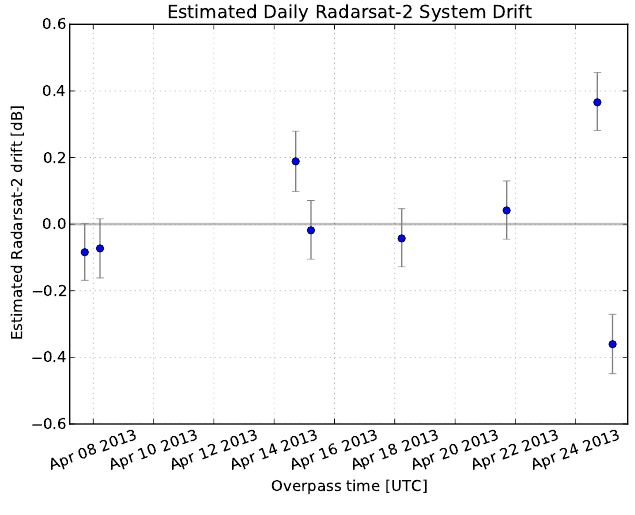
Figure 11. Estimated daily drifts r d of the RADARSAT-2 system. The error bars indicate 95% highest-probability density intervals.